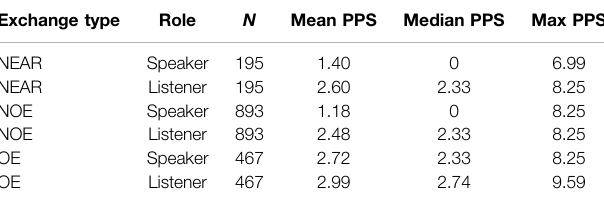
TABLE 4 | Turn Approach Head PPS summary statistics (pooled over participants).